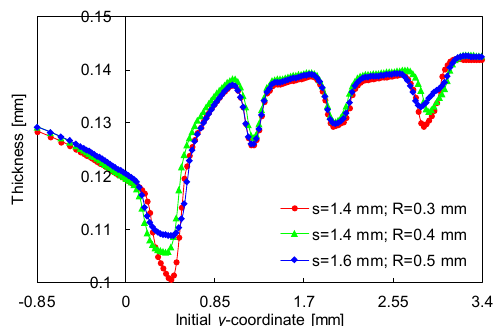
Figure 22. Thickness distribution in the flow channel at x = 0, comparing three different geometries of the die. The parameters are w 1 = 1.2 mm, r = 0.3 mm, and h = 0.7 mm.